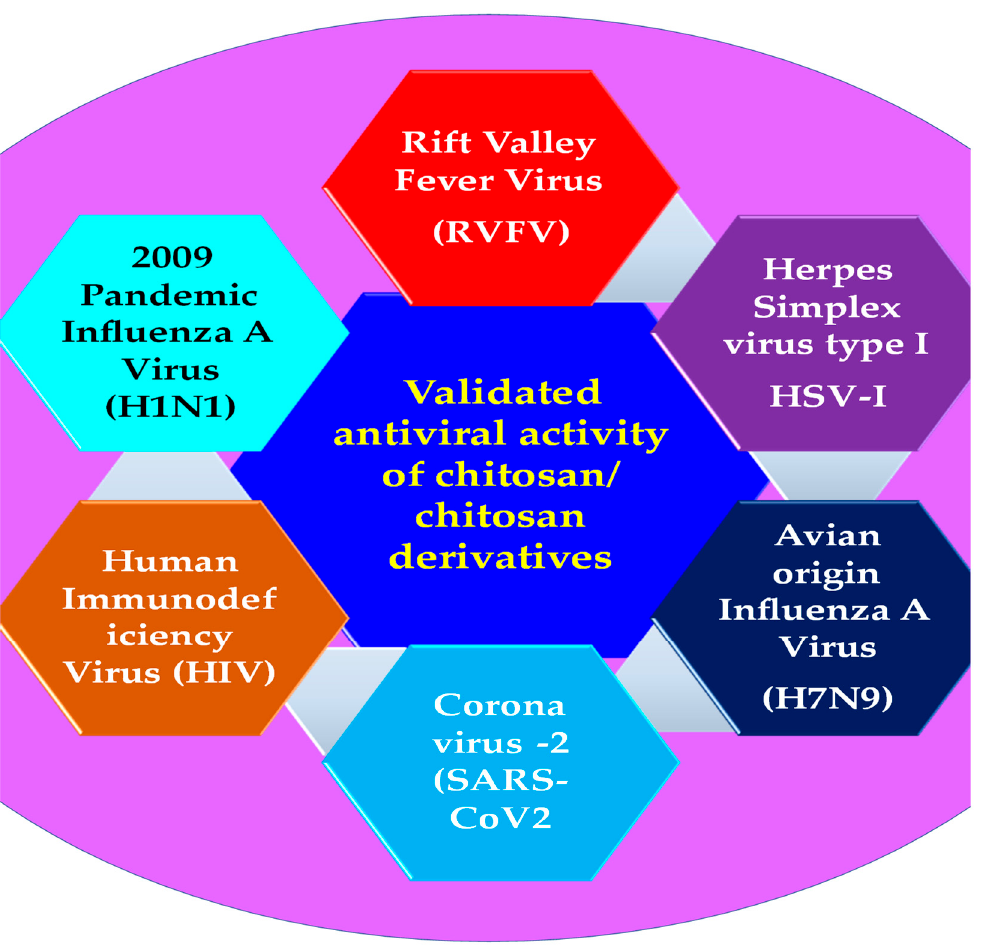
Figure 2. Overview of the various viruses that are susceptible to the antiviral activity of chitosan derivatives.